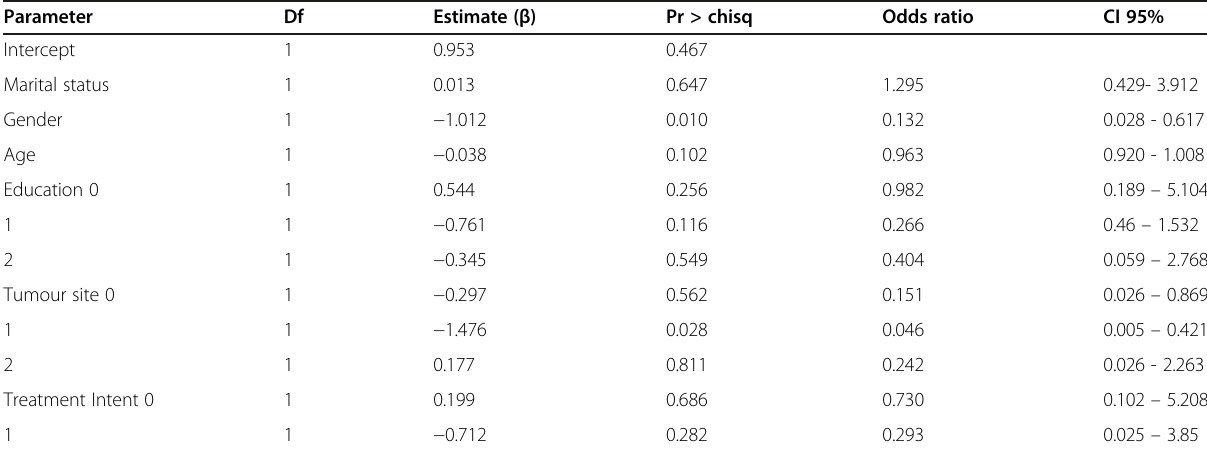
Table 3 Results of logistic regression for the model